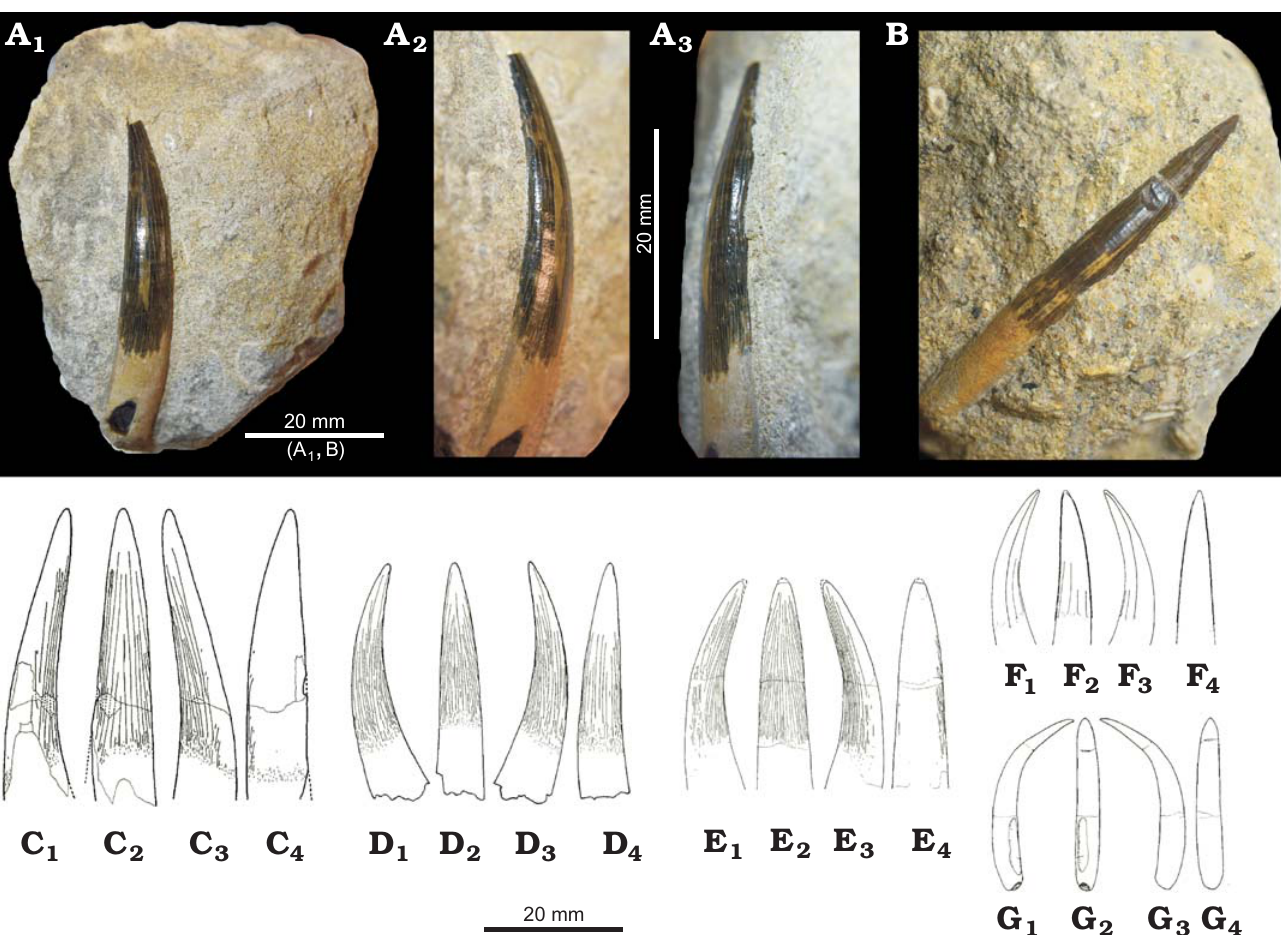
Fig. 3. Teeth of Plesiosauroidea. A . BRSMG Cd5593, cf. Muraenosaurus , from Seend (Whiltshire), lower to middle Oxfordian. B . OUMNH J.47559, Cryptroclididae indet., from Headington (Oxfordshire), middle Oxfordian. C . NHMUK PV R 2861, Muraenosaurus leedsi Seeley, 1874, from Peter- borough (Cambridgeshire), Callovian. D . NHMUK PV R3539, Tricleidus seeleyi Andrews, 1909 from Peterborough (Cambridgeshire), Callovian. E . CAMSM J.30070, Cryptoclididae indet. from Ely (Cambridgeshire), Kimmeridgian. F . NHMUK PV R8621, Cryptoclidus eurymerus (Phillips, 1871) from Peterborough (Cambridgeshire), Callovian. G . NHMUK PV R8431, Kimmerosaurus langhami Brown, 1981 from Endcombe Bay